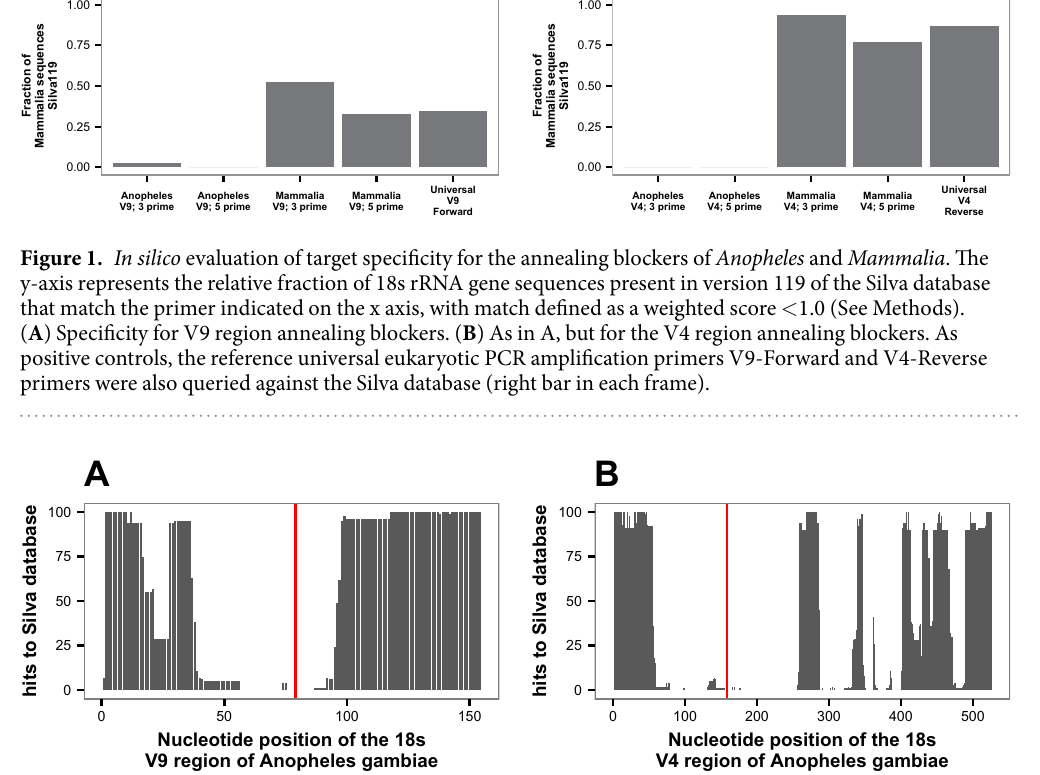
amplicons were sequenced, and the blocking efficiency of both kinds of blockers was determined as the fraction of residual Anopheles (host background) amplicons obtained in each sample and blocking condition. A total of 5,052,260 paired-end MiSeq reads were generated for V4 amplicons, with an average of 157,883.125 paired-ends reads per sample after the demultiplexing step. Of these, 4,137,310 (81.89% of the total) full-length V4 amplicons were reconstructed after quality filtering and joining steps (129,290.94 amplicons per sample on average), and clustered into 119 Operational Taxonomic Units (OTUs) of a minimum size of 5 reads from which the taxonomic profiles of the samples across all conditions (with/without PNA blockers or PCR annealing block- ers) were determined by sequence similarity against the 18s rRNA gene subdivision of Silva database version 119. As expected, mosquito was the predominant taxonomic group in V4 amplicons from samples amplified with- out any blocker, ranging from > 99% of the amplicons in larval samples to 80–97% of the amplicons in human and animal fed samples (Fig. 3). The lower percentage of mosquito reads in human and animal fed samples is a consequence of the amplification of sequences derived from the bloodmeal. The efficiency of PCR annealing blockers was negligible, with the corresponding samples showing a taxonomic profile similar to the samples without any blocker, dominated by mosquito sequences. The annealing blocking primers did shift the reaction threshold cycle (Ct), indicating interference with PCR amplification, but data below indicate that this effect was probably non-specific. As a general rule, fairly permissive hybridization conditions are preferred for microbiome profiling, so increasing PCR stringency in an effort to improve annealing blocker performance would in turn